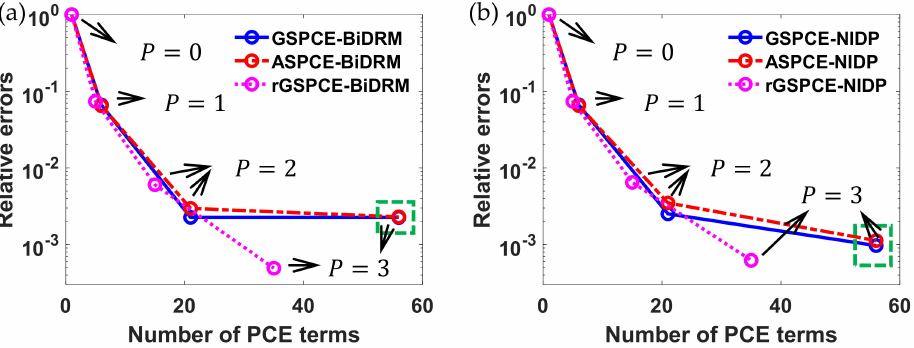
Figure 6. Comparison of the average relative error of the variance for F B with different ( a ) BiDRM- and ( b ) NIDP-based PCE